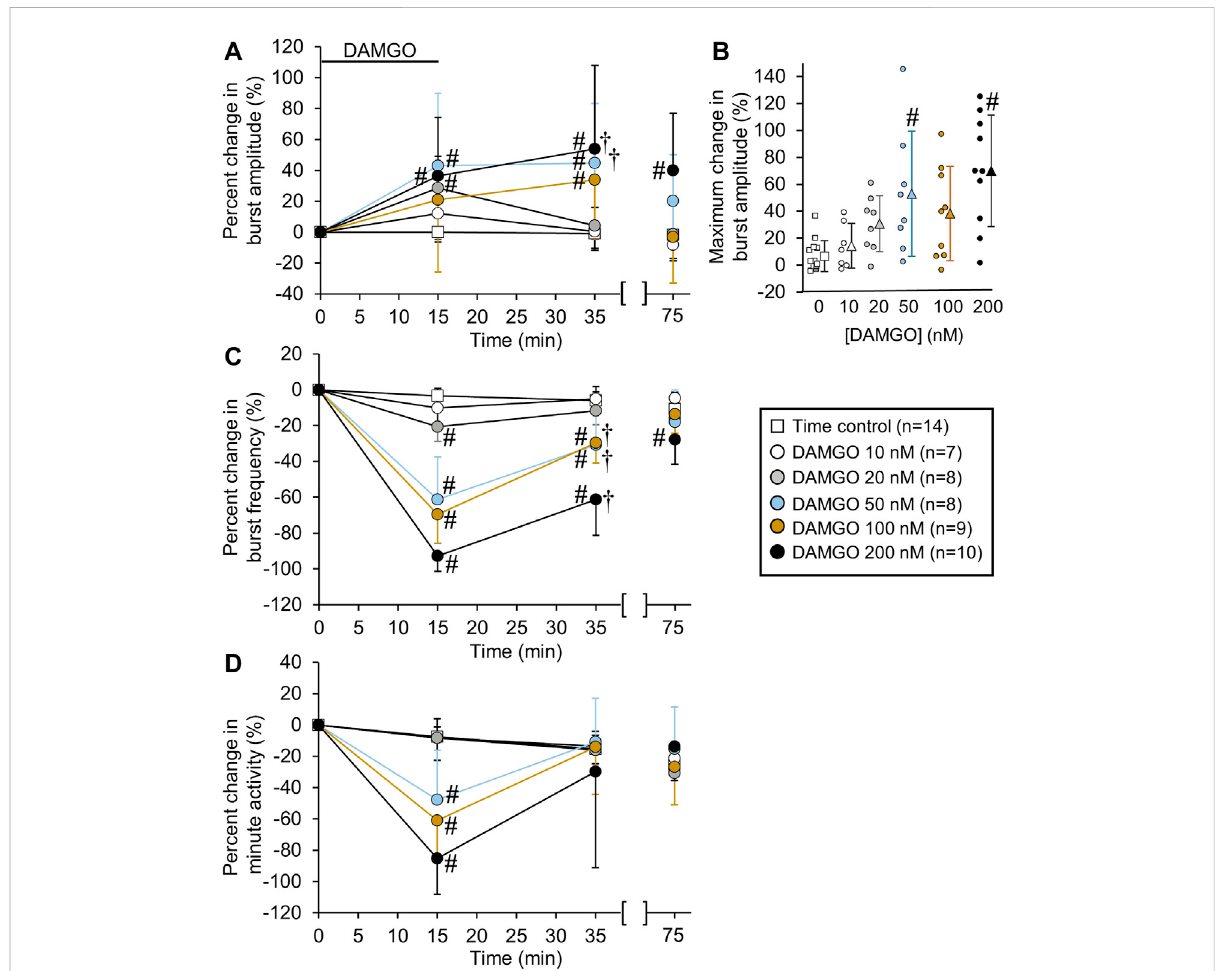
FIGURE 2 DAMGO increased inspiratory-related motor burst amplitude and decreased burst frequency. (A) Percent change in burst amplitude relative to baseline for untreated time controls (white squares) and preparations exposed to DAMGO at 10 nM (white circles), 20 nM (gray circles), 50 nM (blue circles), 100 nM (brown circles), and 200 nM (black circles). The 15-min time point represents the steady-state response after a 15-min DAMGO application, and the 35-min time point represents the time after 20 min of washout. The 75-min time point represents the time after 60 min of washout. (B) The maximum percent change in burst amplitude is shown for the time controls and each DAMGO concentration. The maximum percent change inburstamplitudeoccurred during DAMGO applicationorthewashoutperiod. The circles represent individual experiments andthe triangles (following the same color scheme as the circles for the DAMGO concentrations) represent the mean maximum percent change in burst amplitude. (C) Burst frequency was decreased at nearly all DAMGO concentrations and returned to near baseline levels after 60 min of washout.